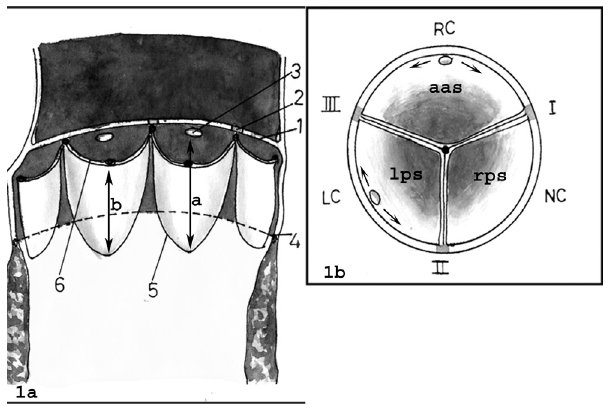
Figure 1a - Schematic diagram of an opened aortic orifice showing: 1 - sinu- tubular ridge; 2 - commissures; 3 - coronary ostium; 4 - ventriculoarterial junction; 5 - attached margin of the aortic cusp; 6 - free upper margin of the aortic cusp. Arrows a and b indicate the heights of the ostium and the cusp from the bottom of the sinus, respectively Figure 1b - The aortic orifice viewed from the arterial aspect in order to show the aortic sinuses; ‘aas’ indicates the right coronary artery (RC); ‘lps’ indicates the left coronary artery (LC), and ‘rps’ indicates the non-coronary sinus (NC). Commissures (I, II, III) can be seen. Arrows indicate the cir- cumferential deviation of the ostia towards the commissures